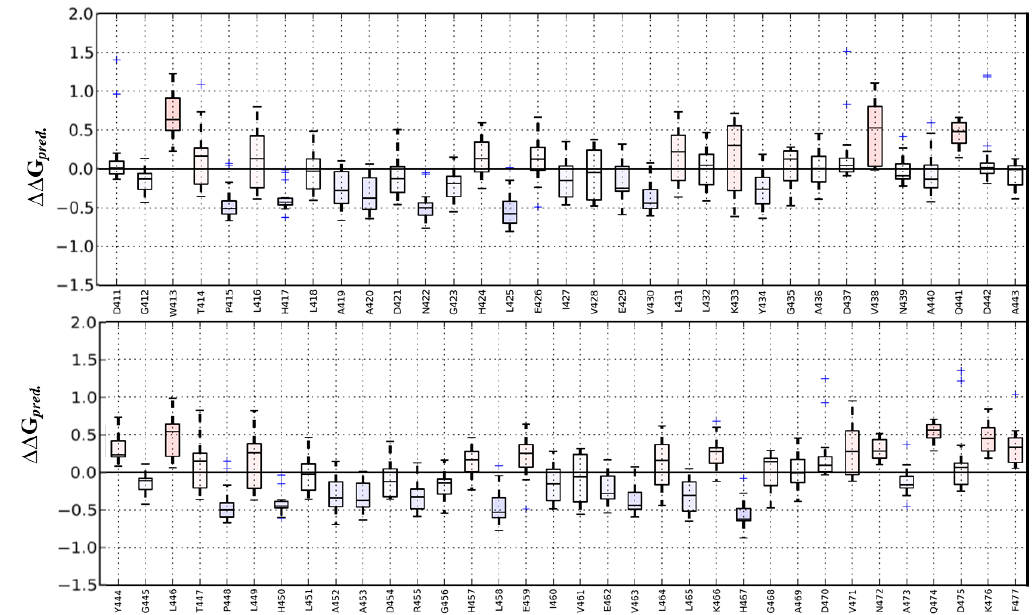
Figure 2. Mutation-sensitive profile of the complex E40/ERK2 obtained from MAESTRO. Confidence estimation and prediction error on multi-point mutations are shown. Blue and red bars show stabilizing and destabilizing mutations, respectively.